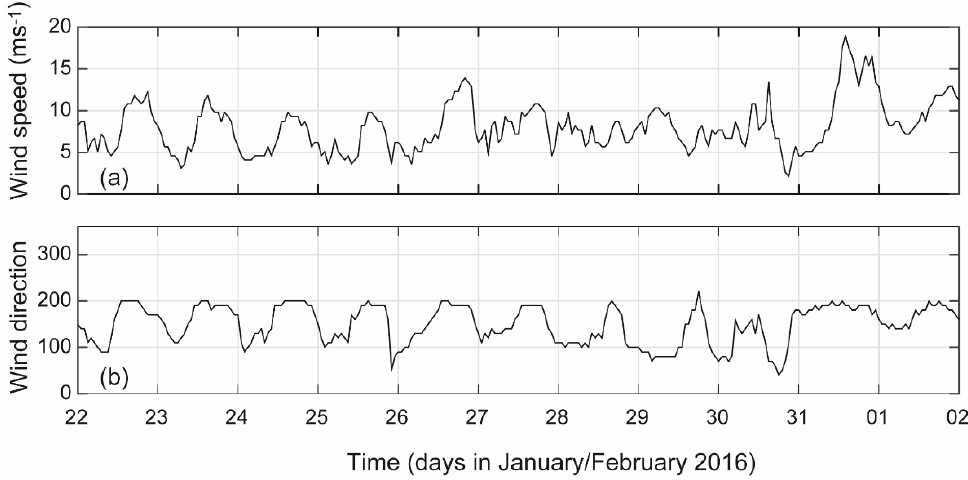
Figure 3. Time series of ( a ) wind speed; and ( b ) wind direction over the period 22 January to 1 February 2016. Data from the Rottnest Island meteorological station. The wind direction is according to the meteorological convention.